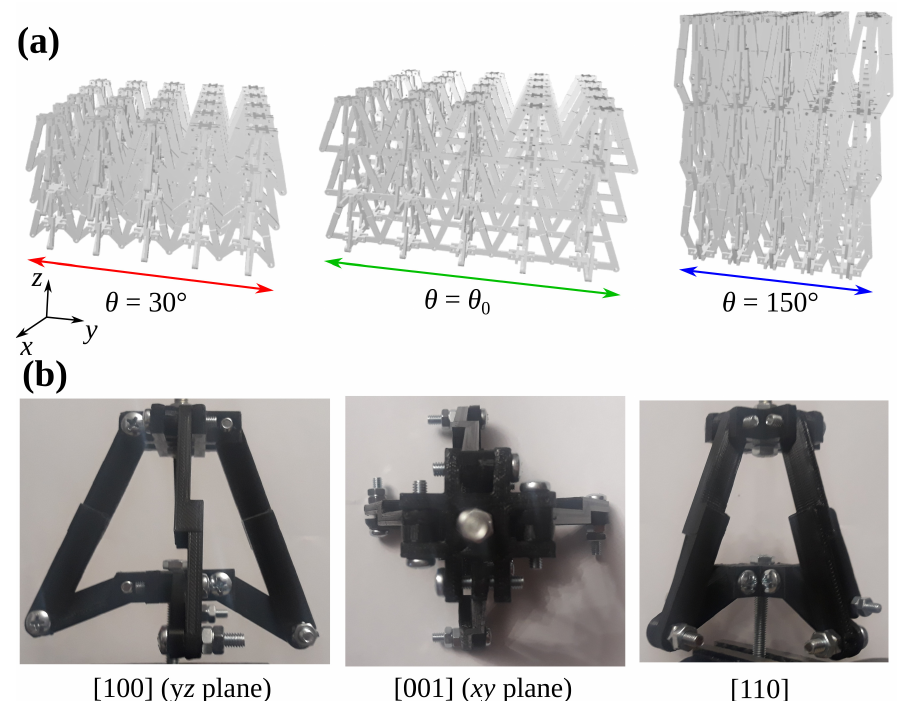
Figure 2. Panels show ( a ) an example of how the considered system would look at different configurations associated with a change in θ should it be constructed by means of structural units like the one shown in Figure 1b, and ( b ) projections of the unit-cell of the proposed prototype in different